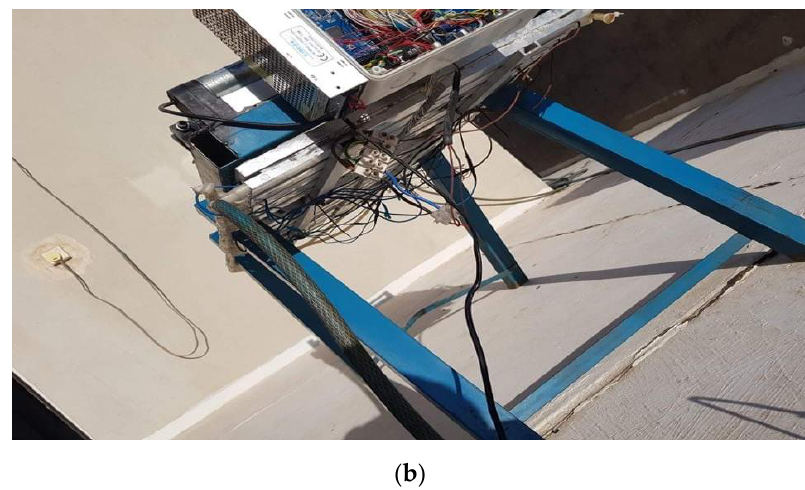
Figure 6. TEG panel exposed to solar radiation with no Fresnel lens, ( a ) Top view, ( b ) Side view.